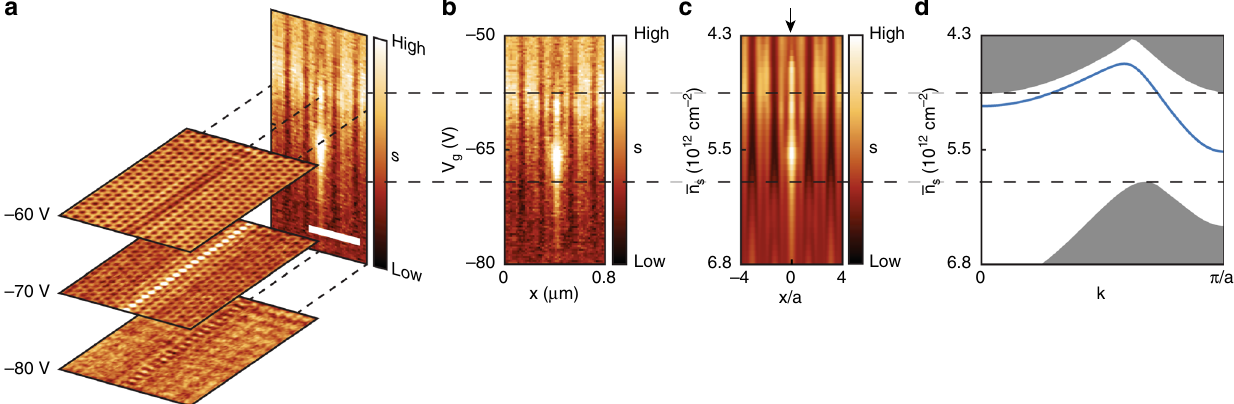
Fig. 3 Gate dependence of the 1D plasmonic domain wall state. a Stacked near- fi eld images (analogous to Fig. 2c) and detailed voltage-dependent contrast across the arti fi cial domain wall (vertical panel) collected at ω = 904 cm − 1 . Scale bar: 400nm. b The same data as panel a vertical panel, displayed in 2D false color map of near- fi eld signal s as a function of gate voltages V g and position x across the domain wall. c Simulated voltage-dependent measurement based on point dipole model. (cid:1) n is the averaged carrier density. The position of the domain wall is marked by an arrow. The lattice periodicity a = 80 nm. s d 1D plasmonic dispersion simulation for the structure shown in Fig. 2a. Gray region corresponds to 2D plasmonic modes. The blue solid line highlights the 1D domain wall